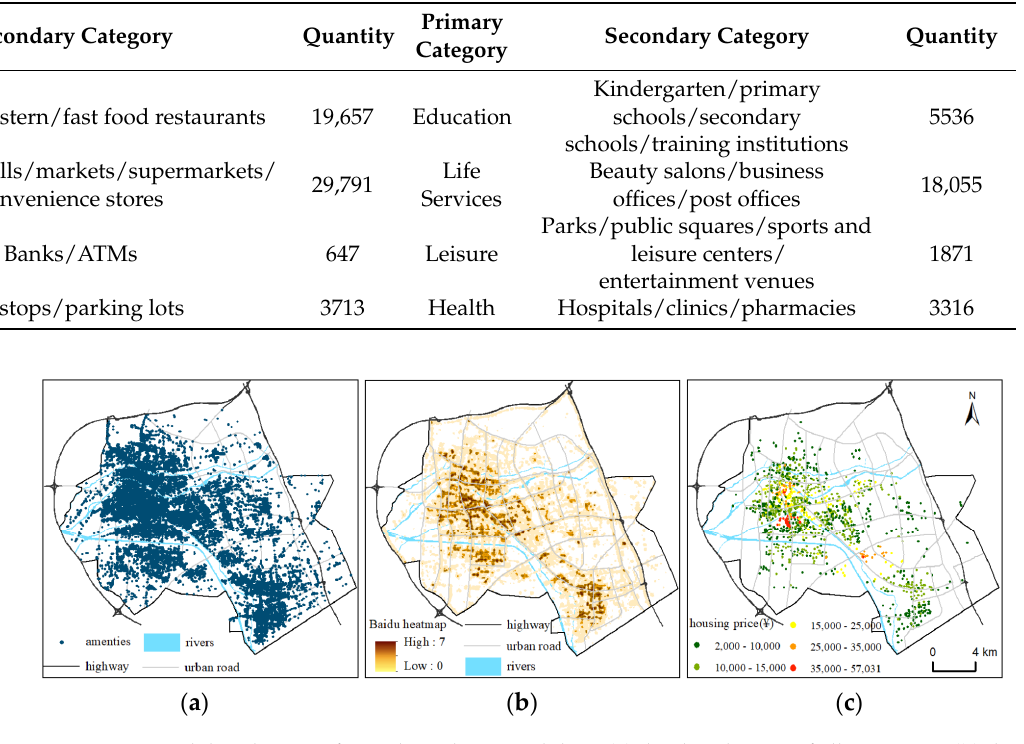
Table 1. Classification of urban amenities.